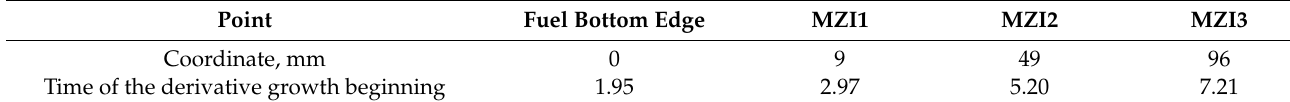
Table 2. Time and coordinates of burning front propagation.